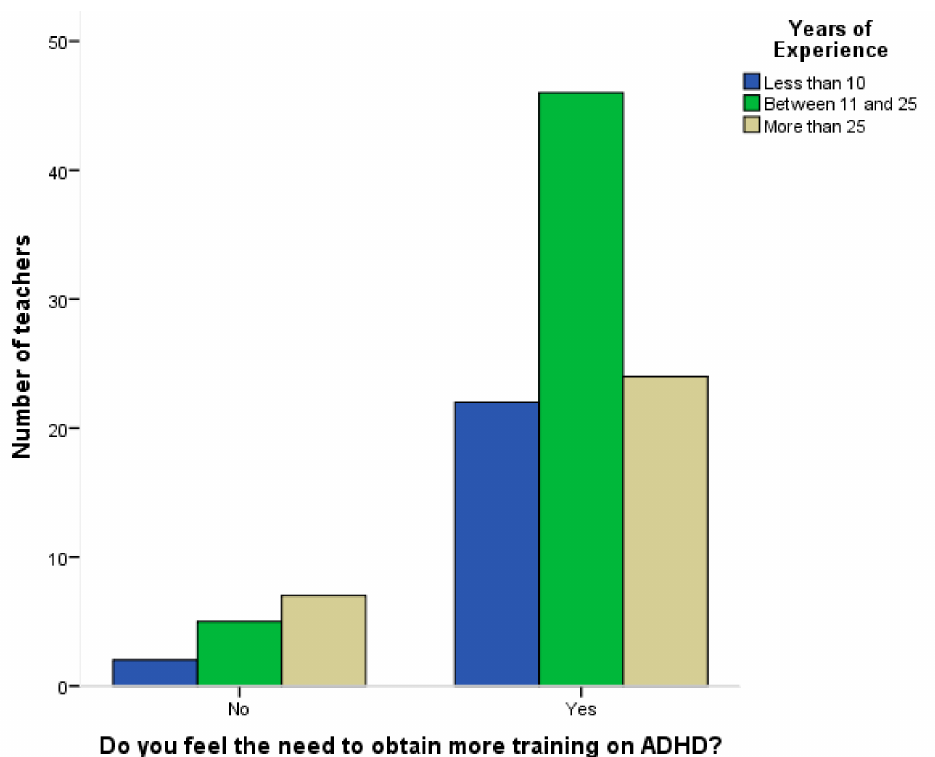
Figure 1. Perception of training needs according to years of